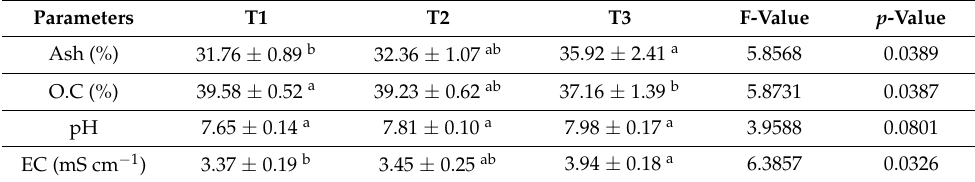
Table 2. Final physicochemical characteristics of vermicomposts obtained from different treatments after 60 days of vermicomposting. T1 = Macrophyte mixture, T2 = macrophyte mixture + cow manure, T3 = Macrophyte mixture + cow manure + nutrient